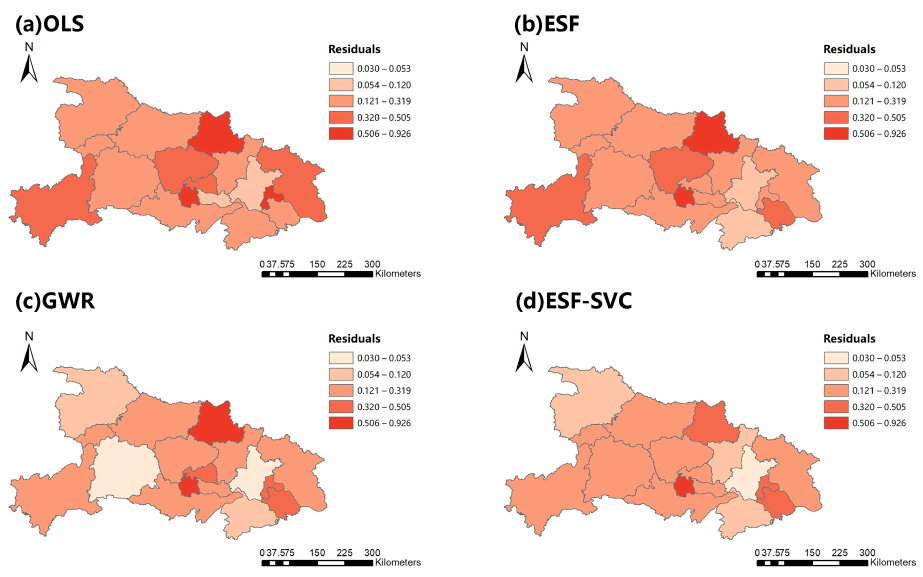
Figure 3. Residual maps for model fitted in Hubei province.